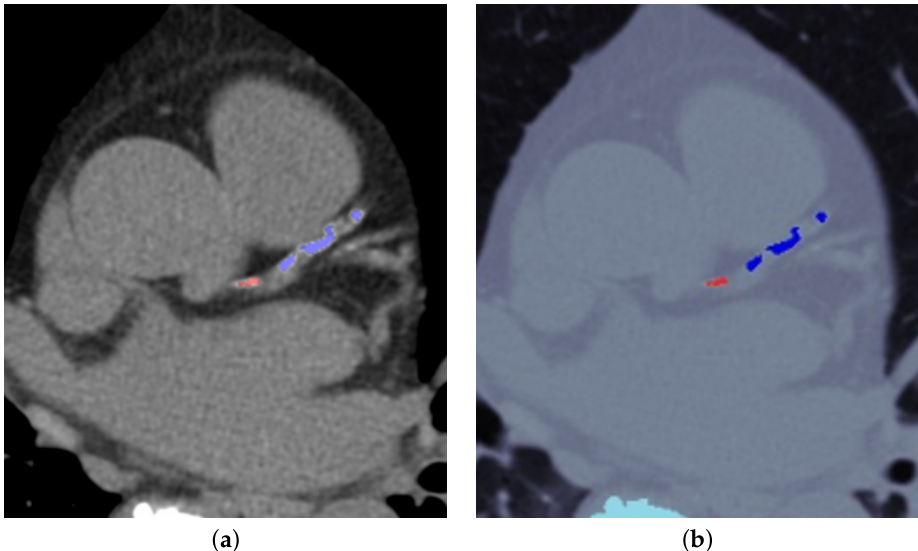
Figure 7. Comparison of the same slice from a CTCS scan. ( a ) Image in Osirix Dicom Viewer. ( b ) Image in web application.